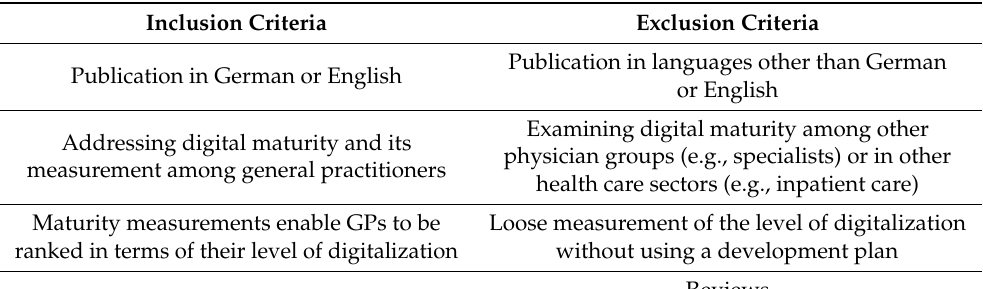
Table 1. Inclusion and exclusion criteria.